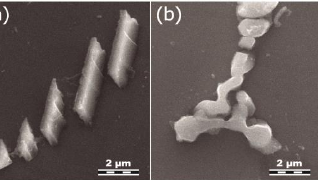
Figure 3. SEM micrographs of the as-cast Fe-10Al-12Valloy showing the morphologies of carbides: ( a ) plate-like (faceted) and ( b ) irregular (non-faceted).